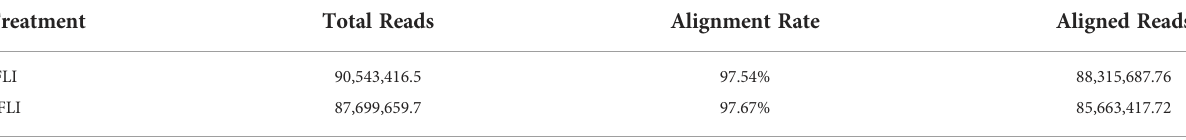
Average total transcript reads and alignment per treatment. n = 4 per